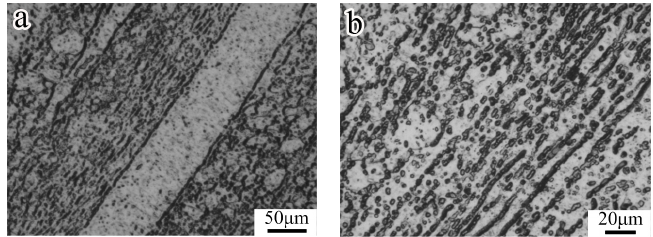
Figure 4. OM images of the longitudinal section of the alloy specimen after isothermal compression ( a ) the macrosegregation; and ( b ) the spheroidized and the elongated α .